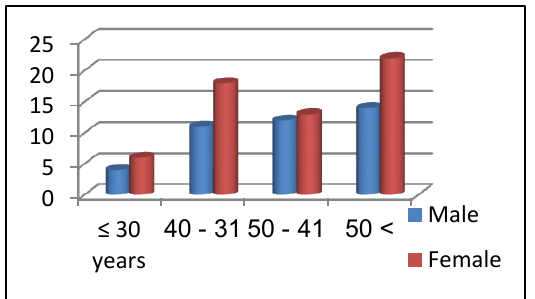
Figure (5) Distribution of patients by gender and age groups